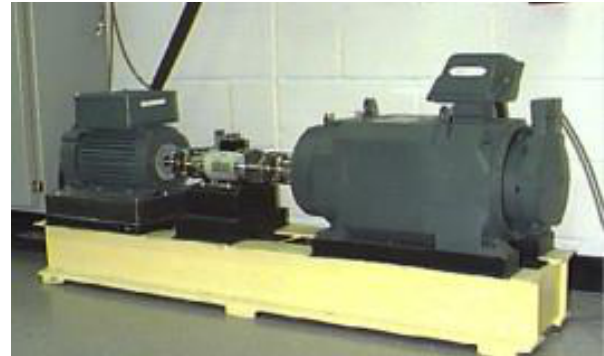
Figure 8. Test rig used in Case Western Reserve University Lab [41].